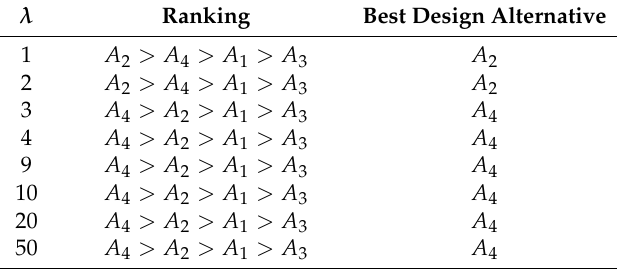
Table 4. The rankings of all design